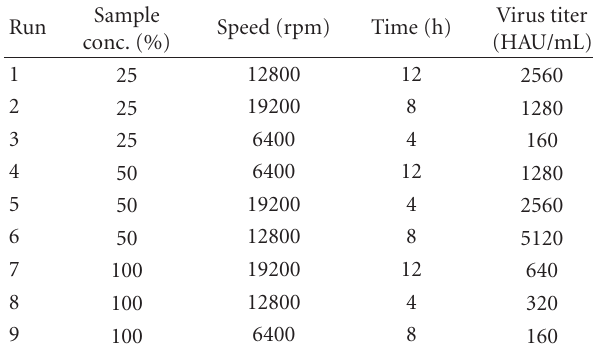
Table 5: Result for high-speed centrifugation.